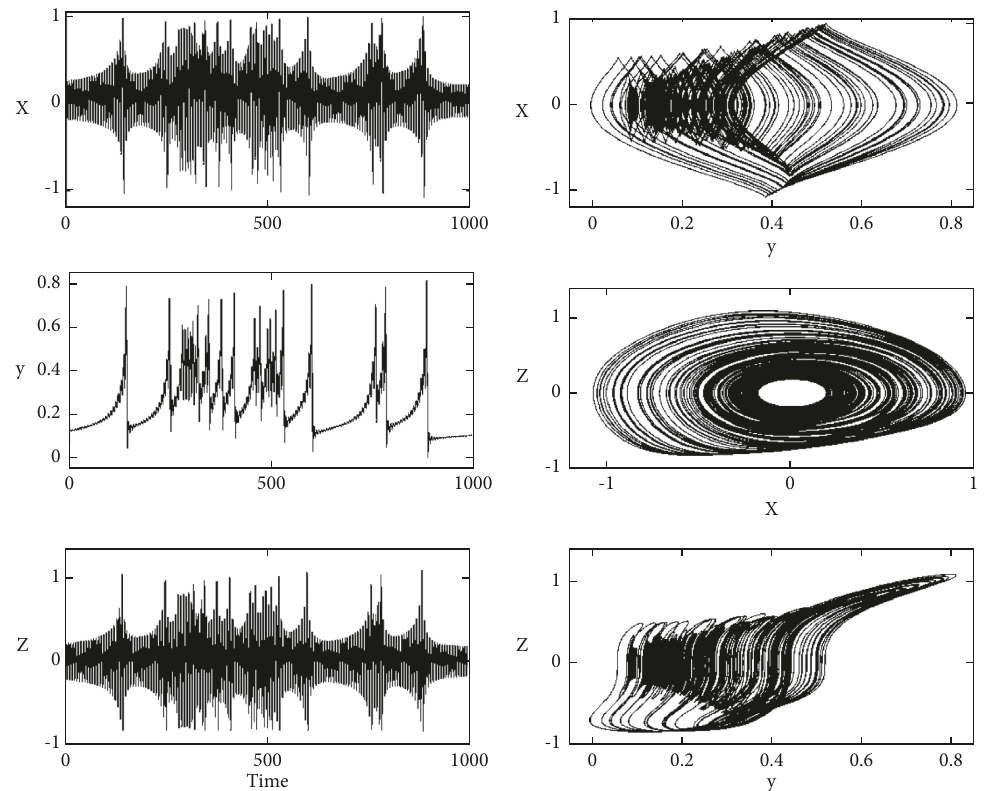
Figure 2: (a) Time series of x